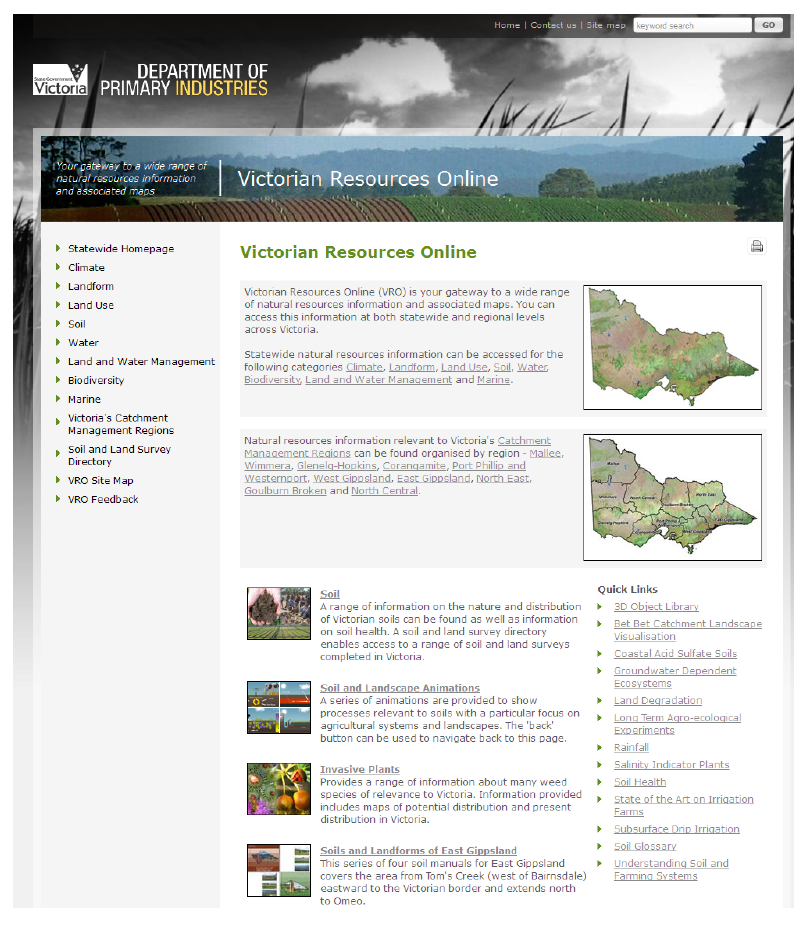
Figure 1. Victorian Resources Online homepage (http://www.dpi.vic.gov.au/vro).  State of Victoria, Department of Primary Industries 1997 Reproduced with